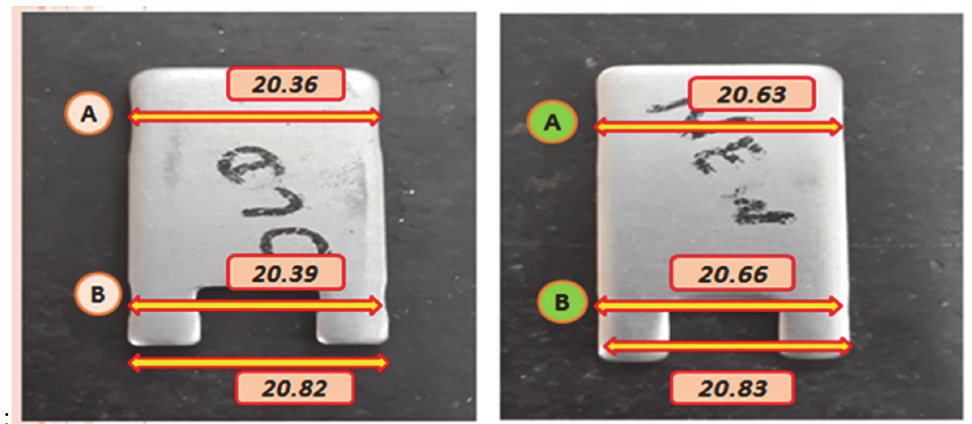
Fig. 8. Lock Nut Dimension Before and